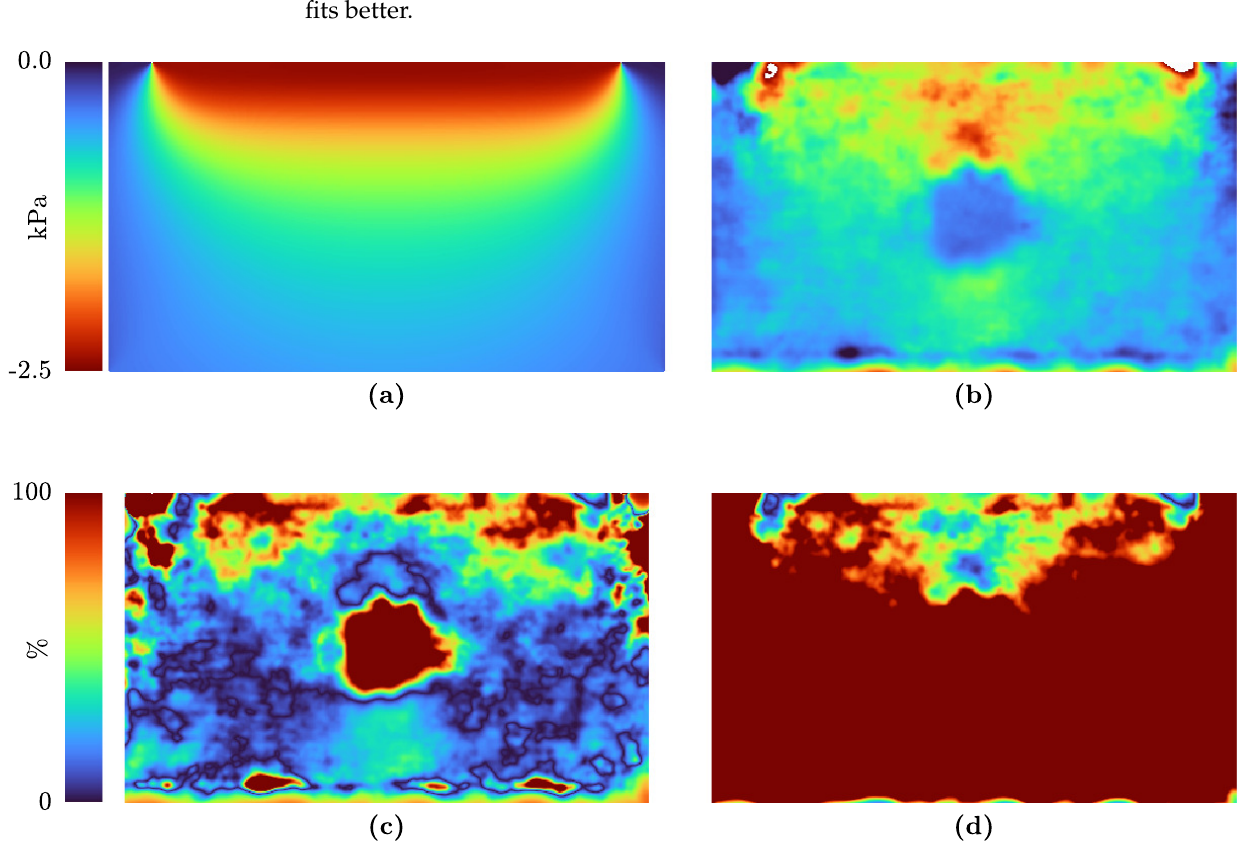
Figure 10. Stress field in a specimen with a stiffer inclusion under compression of 1kPa with the transducer width and depth of 38mm and 8mm, respectively: ( a ) Stress Love’s solution; ( b ) Results of the FE model solved by FEBio; ( c ) Relative error between the FE results and Love’s solution; ( d ) Relative error between the FE results and the plane–stress estimation.